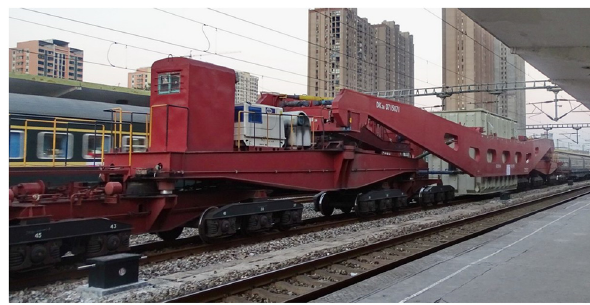
Figure 14: The freight train with transformer transport from Shaling to Shuangzhai.